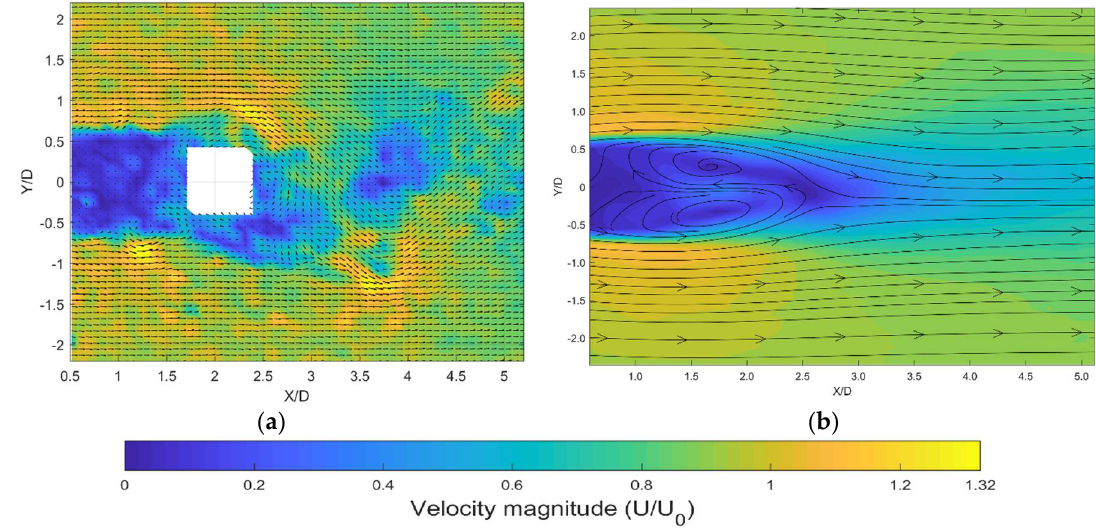
Figure 2. Experimentally obtained flow fields. ( a ) Instantaneous vector field, ( b ) Ensemble average stream lines. Colour represents velocity magnitude, normalized by free-stream velocity, U 0 .